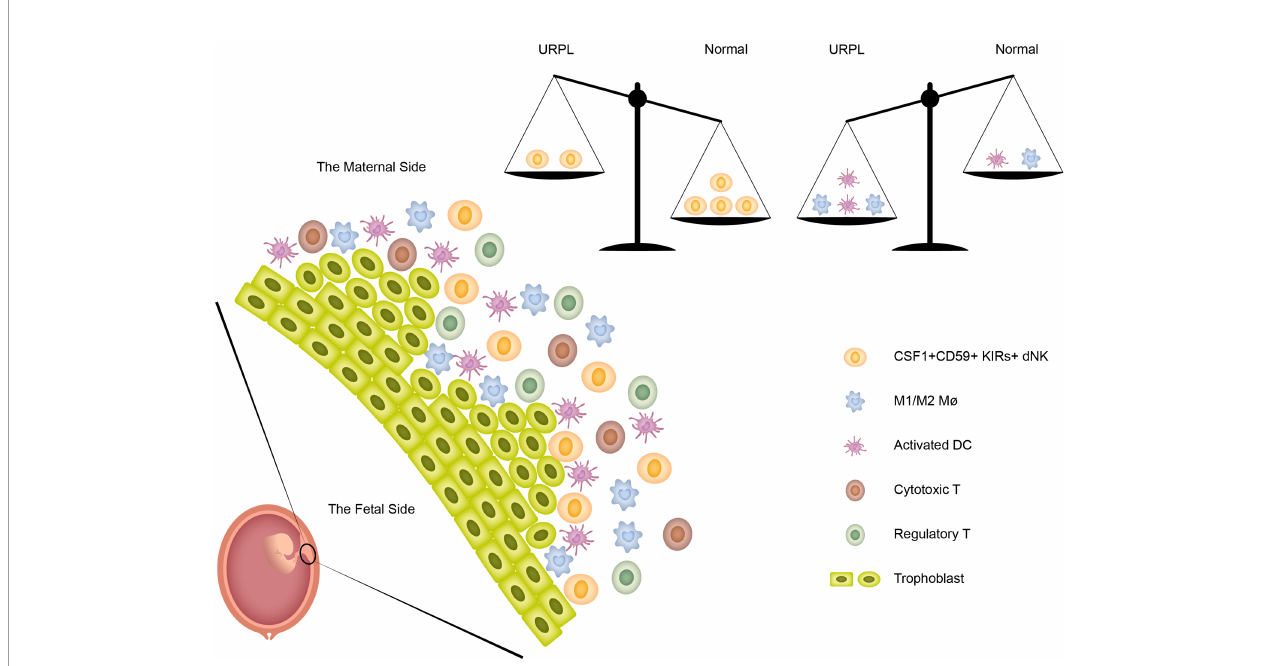
FIGURE 7 | The immune heterogeneity in decidua and the proposed model for the disruption of immune balance in URPL